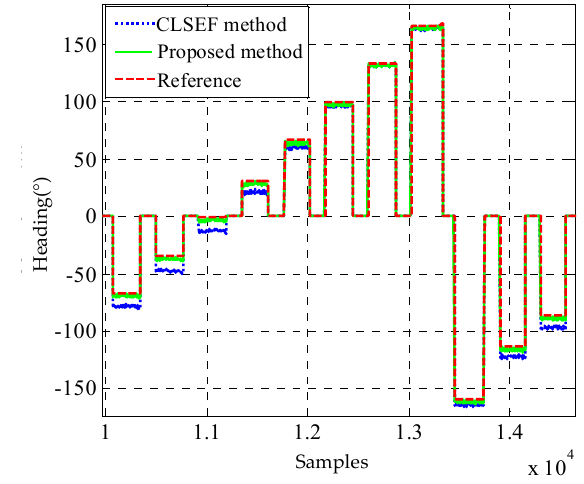
Figure 7. The heading calibration comparison between the CLSEF method and the proposed method.